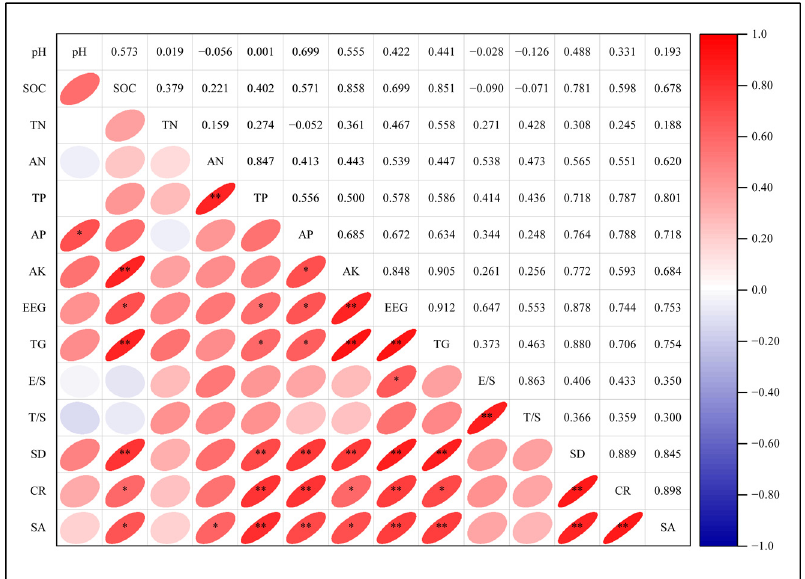
Figure 3. Pearson correlation analysis between GRSP and environmental factors. EEG, EE-GRSP; TG, T-GRSP; E/S, EE-GRSP/SOC; T/S, T-GRSP/SOC; SD, spore density; CR, colonization rate; SA, species abundance. The same below. *, p < 0.05; **, p < 0.01.